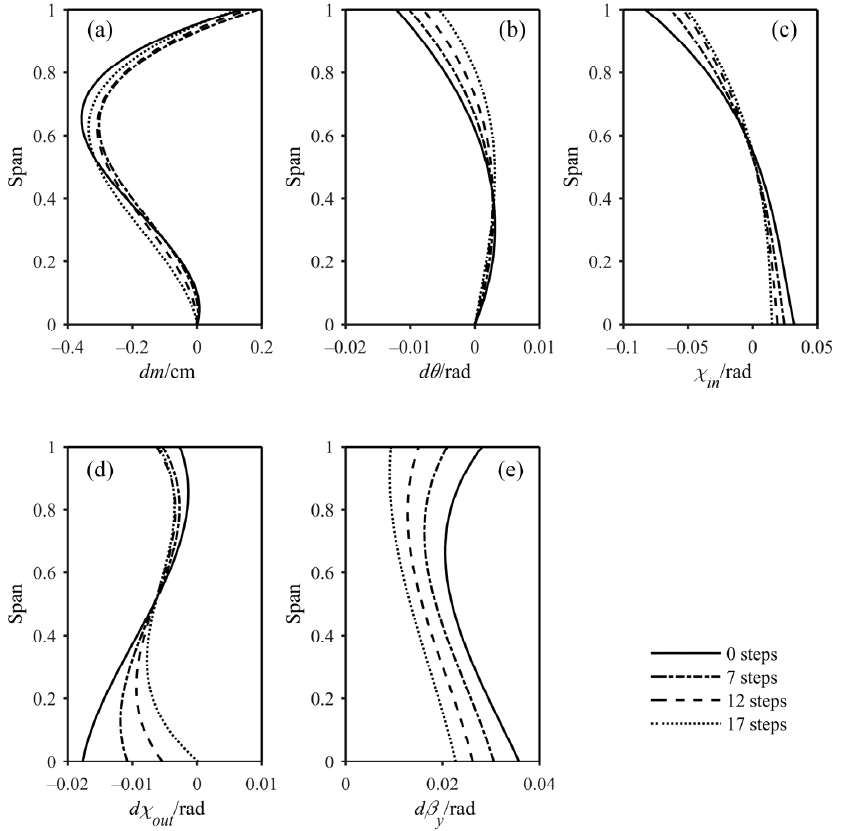
Figure 15. Geometry variation distribution of the span after cooperation: ( a ) meridional coordinate, ( b ) tangential direction, ( c ) inlet camber angle, ( d ) outlet camber angle, and ( e ) incidence angle.